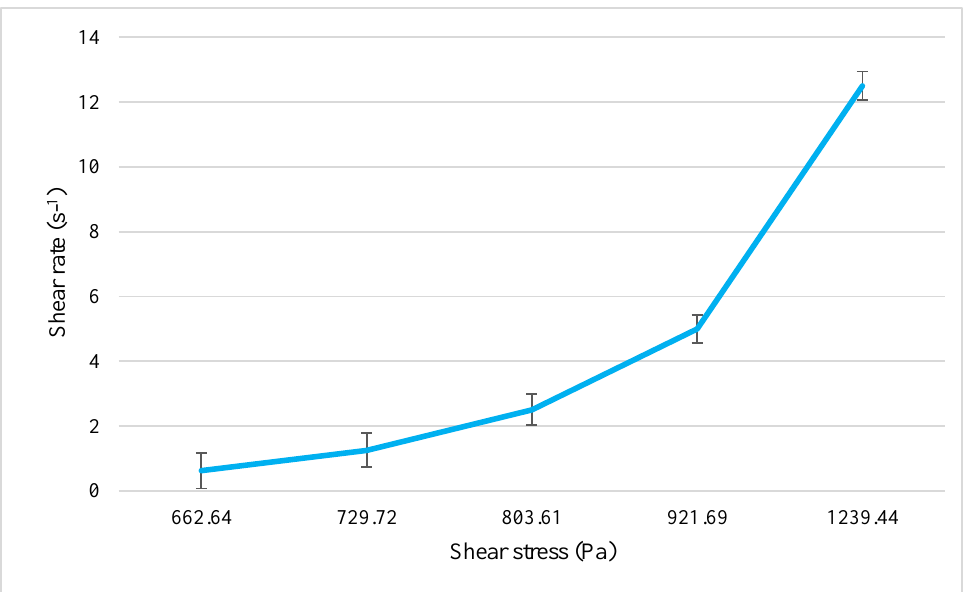
Figure 6. Rheogram of NIO-HAMIN F1 − C emulgel: shear stress as a function of shear rate. Data presented as mean ± SD ( n = 3).